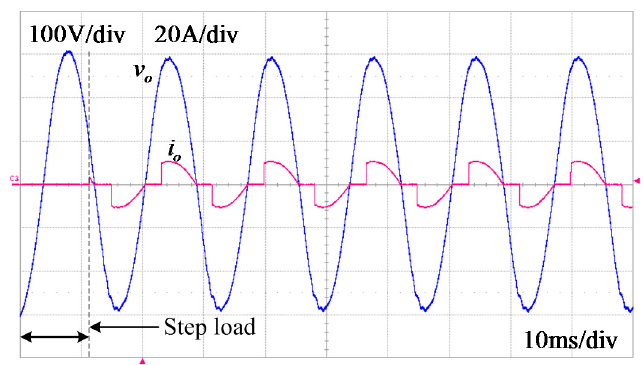
Figure 19. Experimental result under the load step change condition.